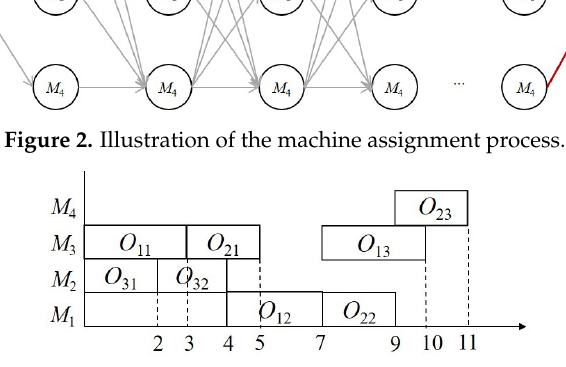
Figure 3. Gantt chart of the illustrated solution for the instance in Table